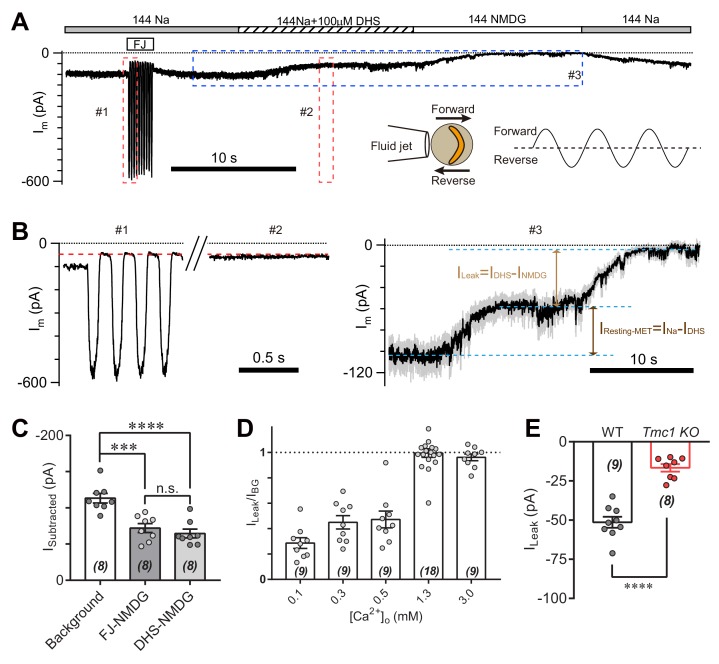
TMC1-mediated leak current is not carried by the resting open MET channel.(A) Representative Im trace showing fluid jet (FJ)-induced open and closed status of MET current and DHS-induced alteration of baseline current. The OHCs were bathed in external solution with 0.3 mM Ca2+ instead of 1.3 mM Ca2+. Insets: left, a diagram of fluid jet stimulation on a hair bundle; right, a 40 Hz sinusoidal stimulation protocol was used to induce forward and reverse deflection of the hair bundle. (B) Dashed frames #1, #2, and #3 in (A) are shown as enlarged traces. The baseline current was similar when the MET channels were closed by either FJ (#1) or DHS (IDHS, #2), as highlighted with a red dashed line. As shown in #3, the DHS-sensitive resting MET current (IResting-MET) was calculated by subtraction of INa and IDHS. The baseline current was further closed by NMDG (INMDG). ILeak was defined as the subtraction of IDHS and INMDG. (C) Quantification of subtracted currents under different conditions: background, –113 ± 7 pA; FJ-NMDG (ILeak subtracted from current baseline closed at negative FJ), –72 ± 6 pA; DHS-NMDG (ILeak subtracted from that closed by 100 μM DHS), –65 ± 6 pA. (D) Quantification of ratio of ILeak to IBG (ILeak/IBG) under different [Ca2+]o conditions: 0.1 mM, 0.29 ± 0.04; 0.3 mM, 0.45 ± 0.05; 0.5 mM, 0.47 ± 0.07; 1.3 mM, 1.00 ± 0.03; 3.0 mM, 0.96 ± 0.03. (E) Quantification of the ILeak of OHCs measured in 1.3 [Ca2+]o. Wild-type ILeak, –51 ± 3 pA, Tmc1-knockout ILeak, –17 ± 2 pA. The external solution contained variable Ca2+ concentration as indicated. The holding potential was −70 mV. Data are represented as mean ± SEM. N values are shown in each panel. *p<0.05, **p<0.01, ***p<0.001, (C) ANOVA; (E) Student’s t-test.10.7554/eLife.47441.009Figure 3—source data 1.TMC1-mediated leak current is not carried by the resting open MET channel.